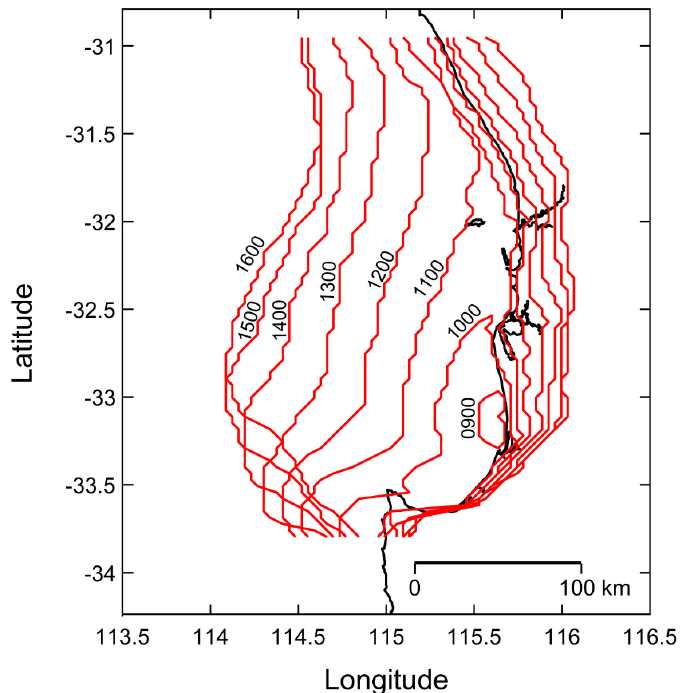
Figure 11. Time variability of sea breeze cell locations at hourly intervals from 0900 to 1600 averaged over a 10-day cycle (1–10 December 2016).